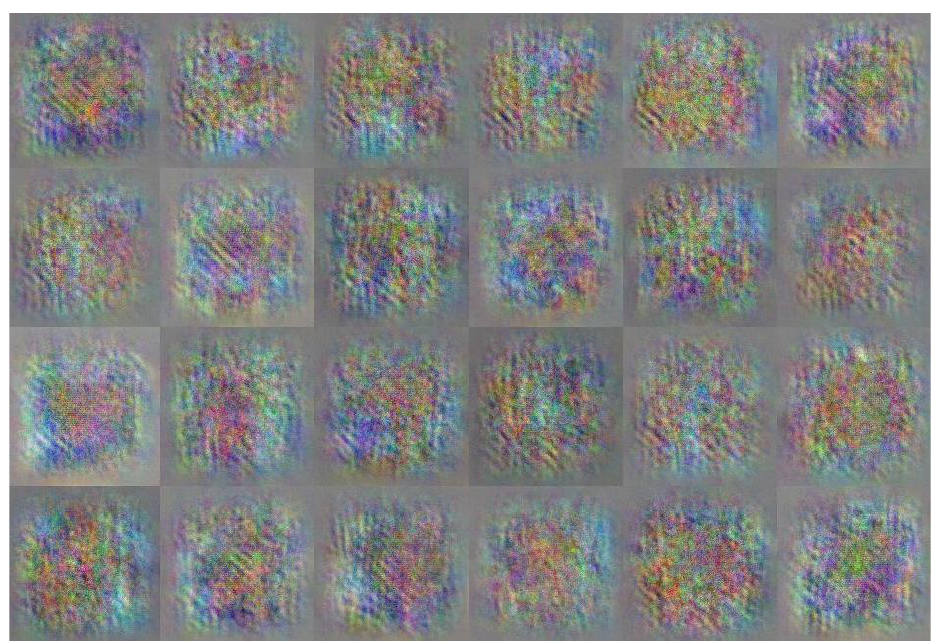
Figure 13. Visualization of C4 layer weights of